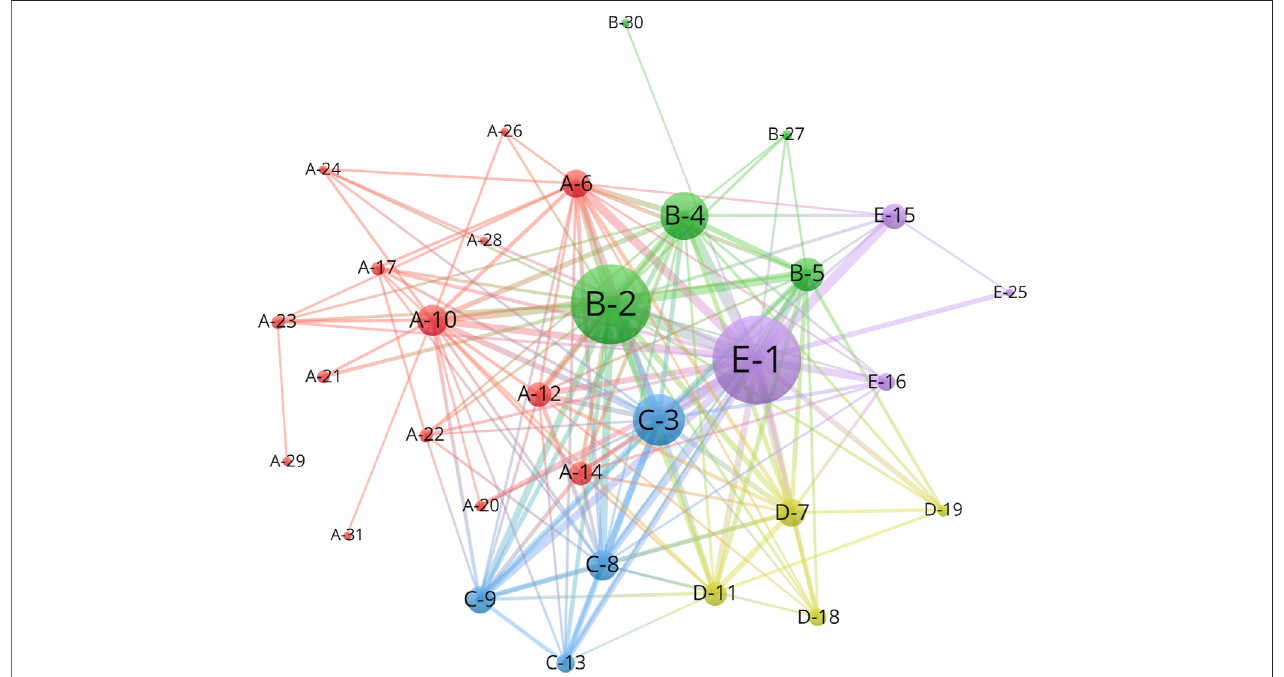
FIGURE 6 | Main countries: a bibliographic coupling network visualization, with each node representing a country ( Table 6 ).